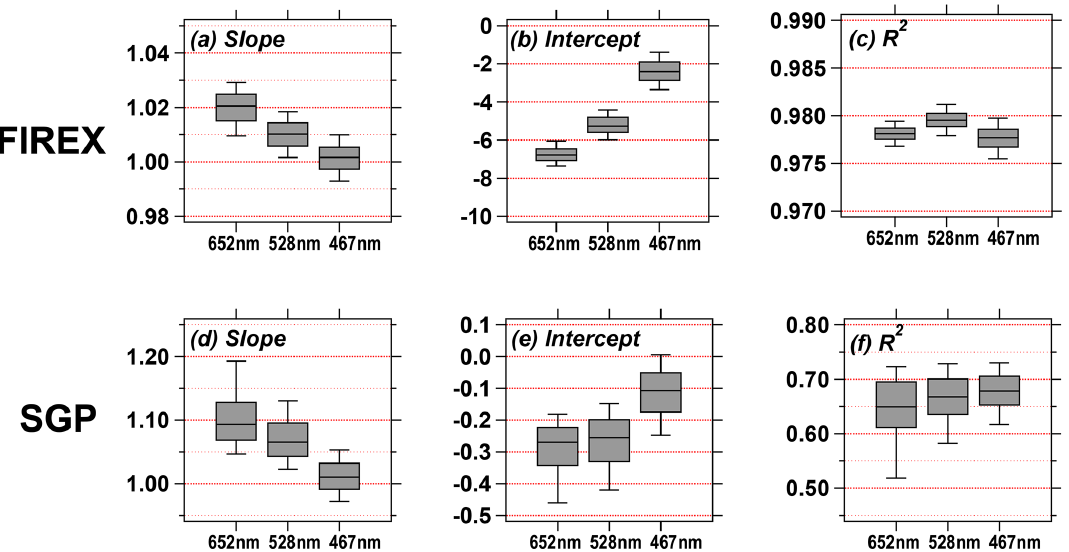
Figure 5. The box-and-whisker plots for the slope, intercept, and R 2 of the relationship between the CLAP-derived B abs (corrected by Algorithm B in the present work) and PAX-derived B abs for all three wavelengths. For details on how these values were generated, please refer to the